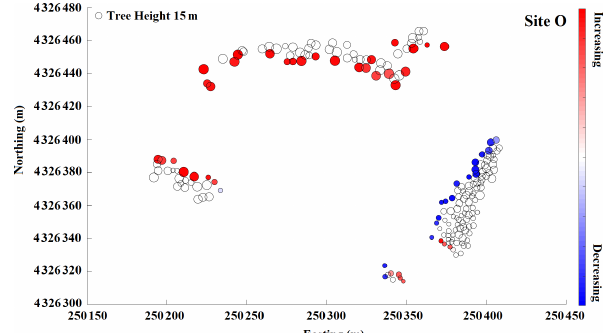
Figure B9. Snow depth change within a 10m buffer from the edge of a tree at site O. Red color indicates snow depth increases moving from the tree edge toward the open areas, and blue indicates snow depth decreases. Increasing and decreasing patterns are shown for individual trees at each site with adequate snow